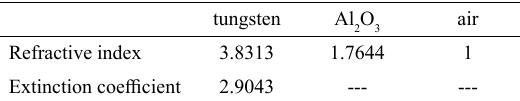
Table 1. The refractive index at the wavelength of 0.667